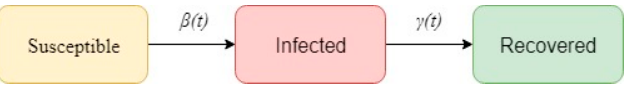
Figure 1. The susceptible-infected-recovered (SIR) model [18].